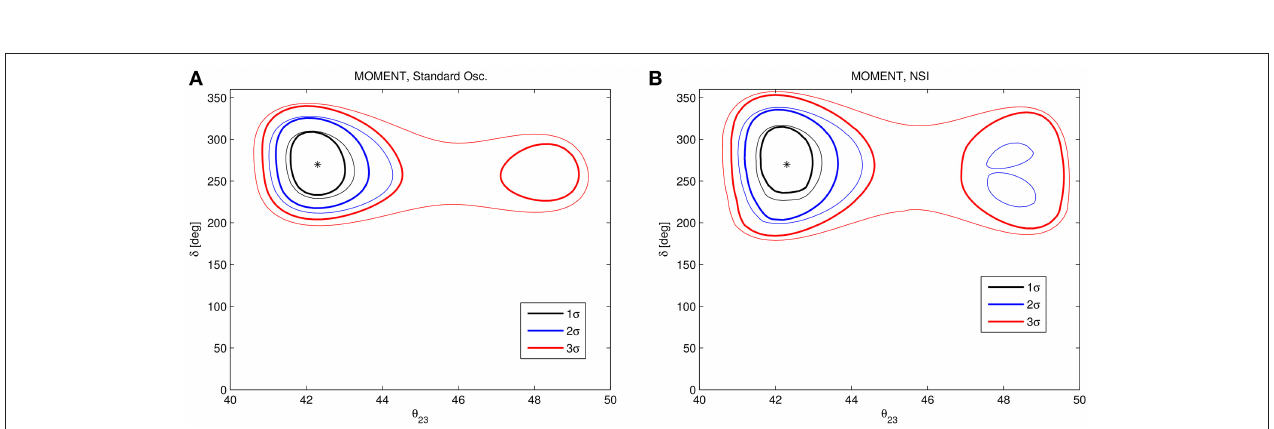
θ 23 on background Suppression Factor (SF). Thick and thin lines respectively show SF −